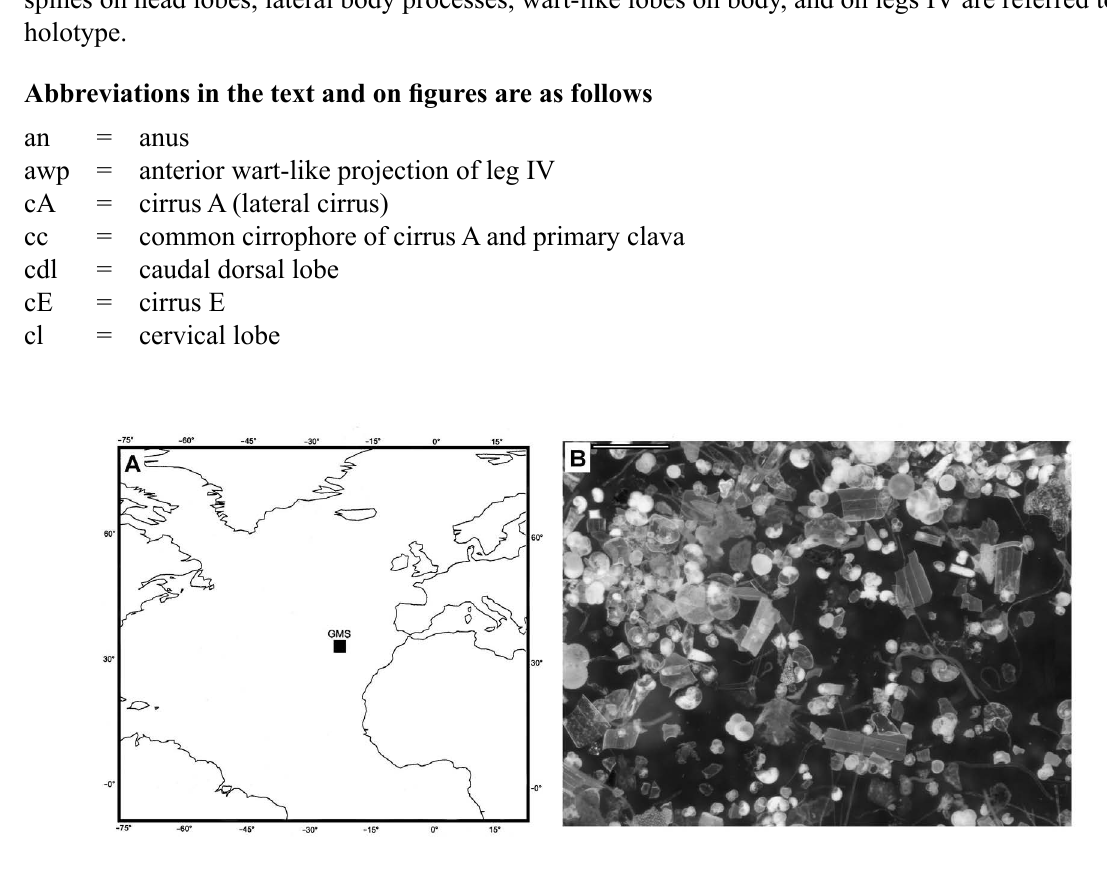
Fig. 1. Type locality and milieu of Neosstygarctus grossmeteori sp. nov. A . Position of the Great Meteor Seamount in the Atlantic Ocean. B . Bioclastic sediment consisting mainly of calcareous foraminiferan and pteropod shells (fine fraction of sediment washed off). Scale bar = 2